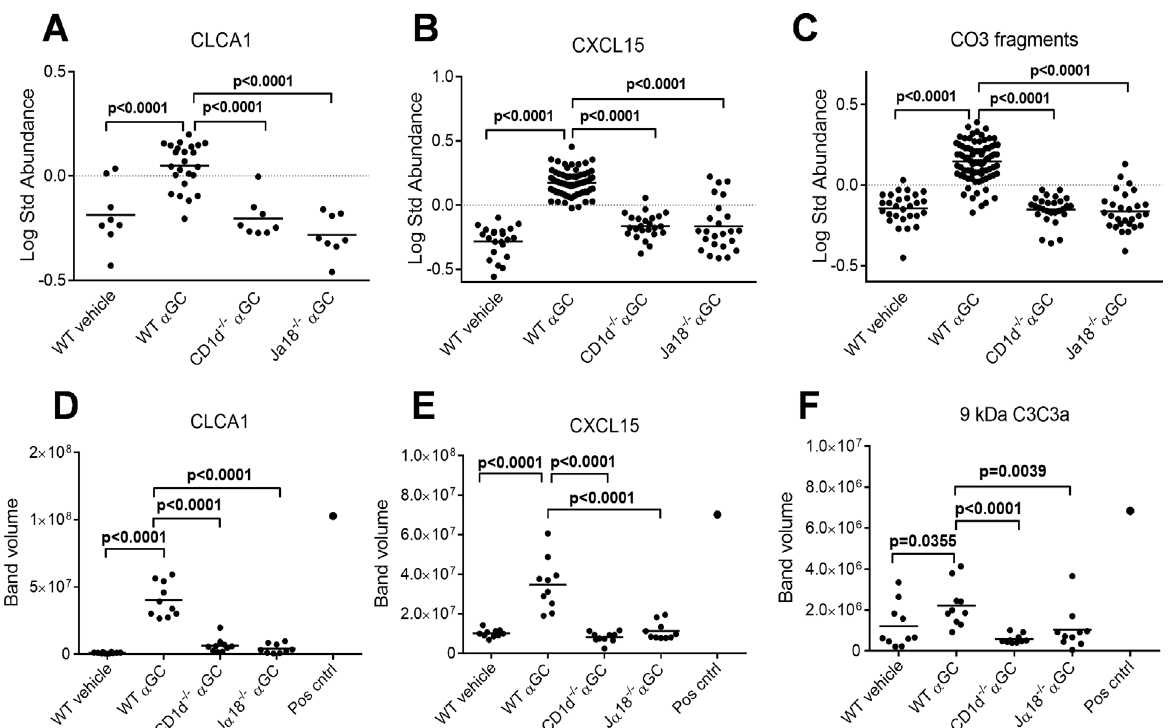
Fig 5. Western blot abundance differences for proteins selected for validation. Protein levels of all identified CLCA1 (A), CXCL15 (B) and complement C3 fragments (C) are shown as dotplots in the study groups as log standard abundance of the gel spots from the DeCyder EDA program. Differences in immunoblot band volumes are shown for CLCA1 (D), CXCL15 (E) and 9 kD C3 fragment called anaphylatoxin C3a (F). Student ’ s t -test p values for significant protein level differences between α -GalCer — treated ( α GC) WT mice and other groups are marked. A BALF sample from ovalbumin-sensitized and challenged mouse was used as a positive control for asthma (Pos